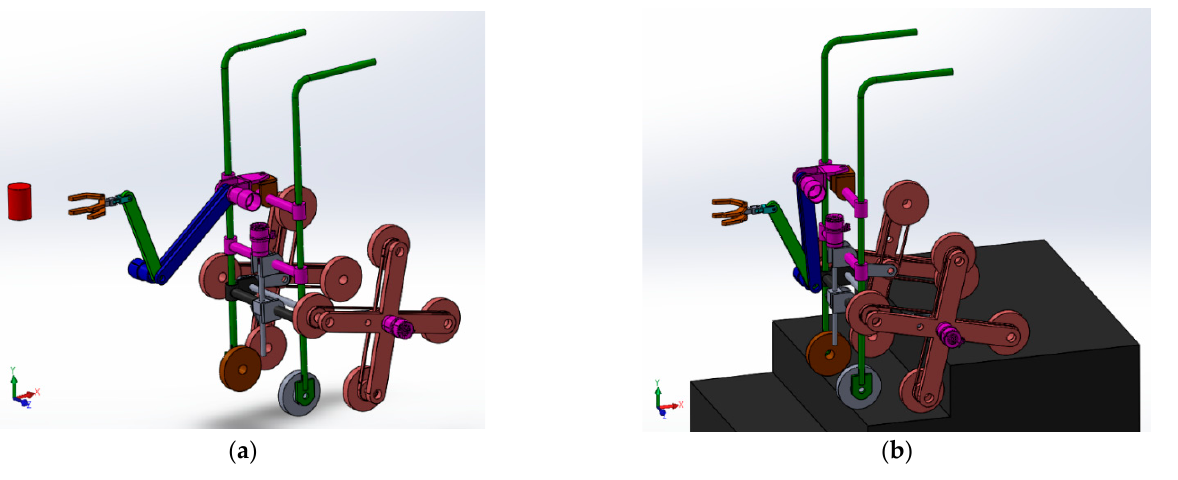
Figure 1. VIPs-Walker design (virtual prototype): ( a ) walker with its robotic arm outstretched to grab an object; ( b ) walker on the stairs.